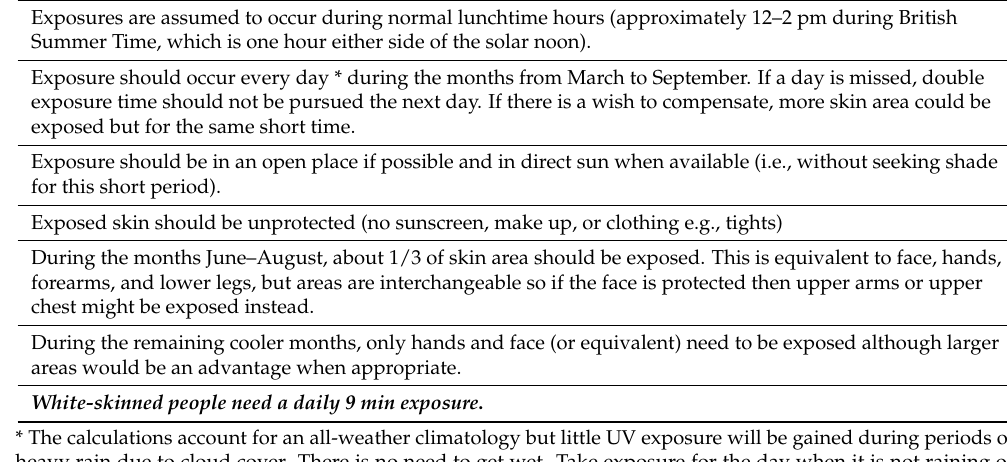
Table 4. Summary for practical application of results (Scenario